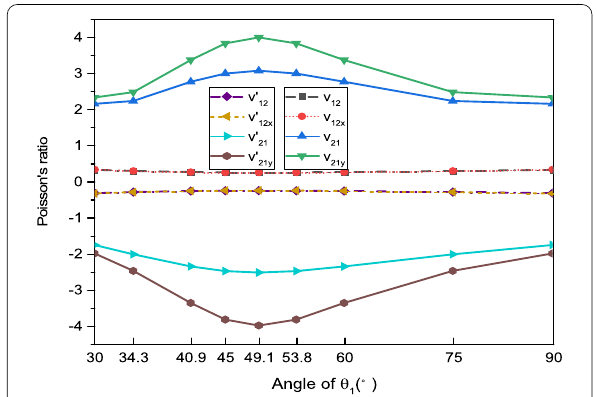
Figure 19 Poisson’s of two structures in the σ 1 and σ 2